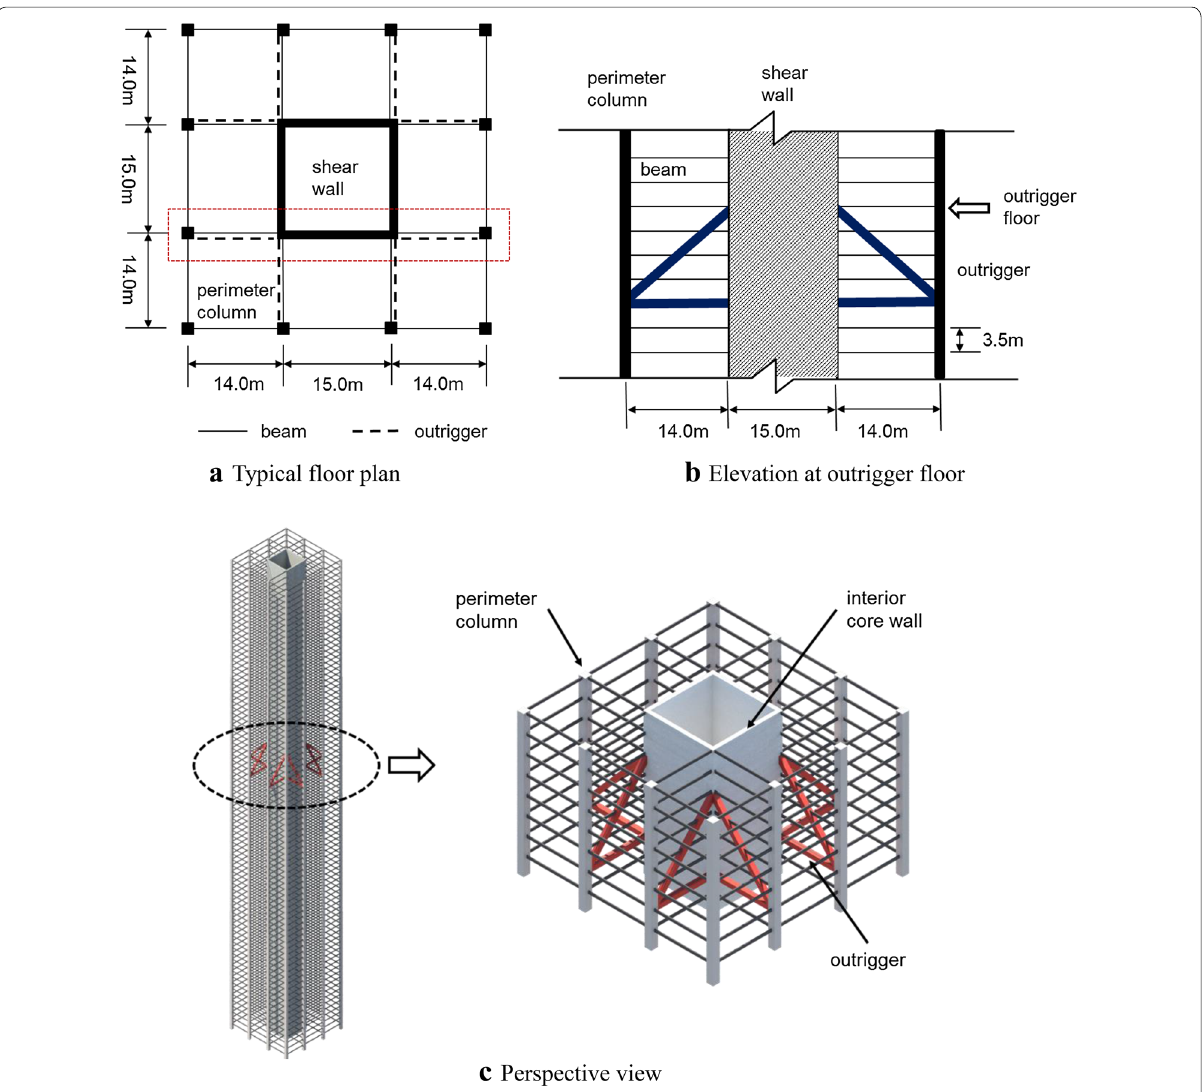
Fig. 1 Analysis models and outrigger